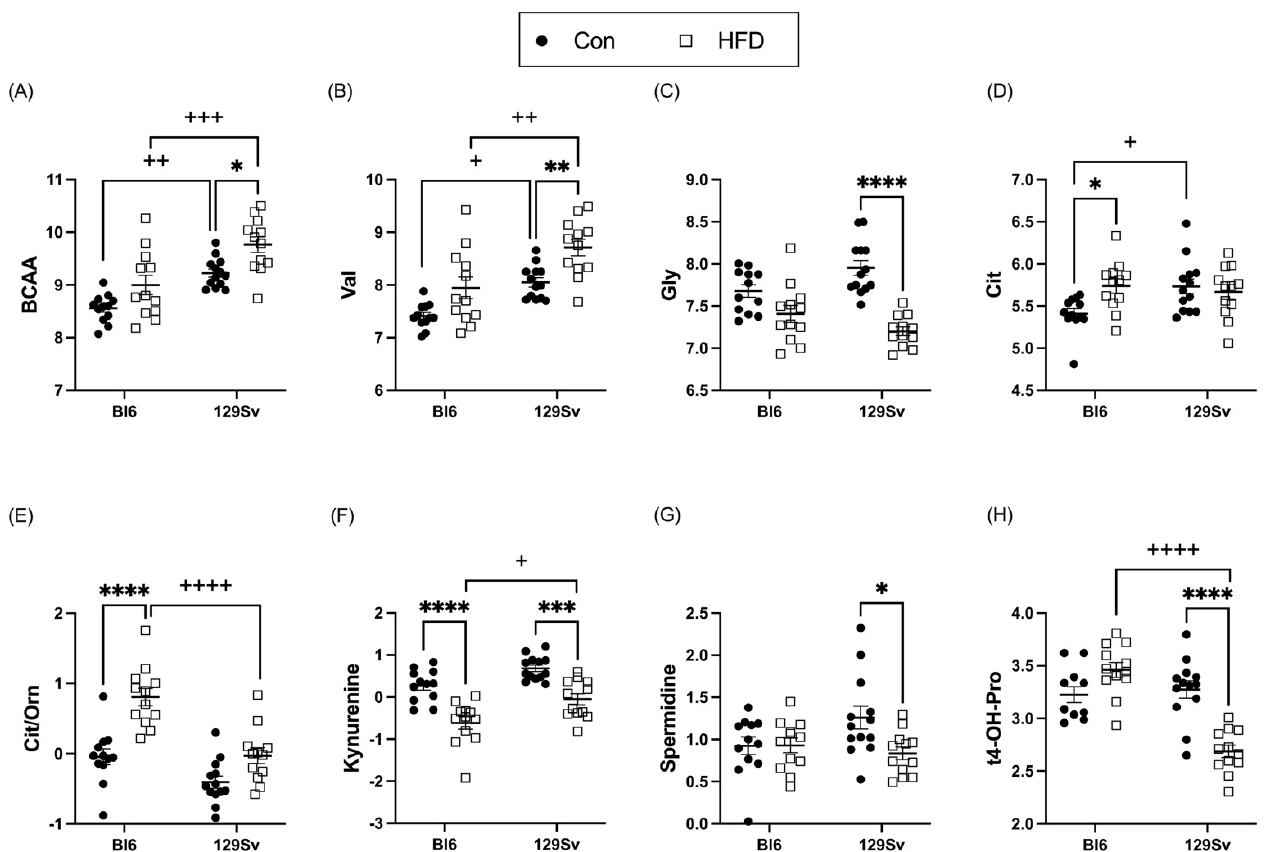
Figure 5. Effect of HFD on the level of selected amino acids and their derivatives biogenic amines (Log2 values, data expressed as mean ± SEM). ( A ) sum of branched-chain amino acids (BCAAs), ( B ) valine (Val), ( C ) glycine (Gly), ( D ) citrulline (Cit), ( E ) ratio of citrulline to ornithine (Cit/Orn), ( F ) kynurenine, ( G ) spermidine, and ( H ) trans-4-hydroxyproline (t4-OH-Pro). Two-way ANOVA (Bonferroni post hoc test): * p ≤ 0.05, ** p ≤ 0.01, *** p ≤ 0.001, **** p ≤ 0.0001 (diet effect), + p ≤ 0.05, ++ p ≤ 0.01, +++ p ≤ 0.001, ++++ p ≤ 0.0001 (strain effect).